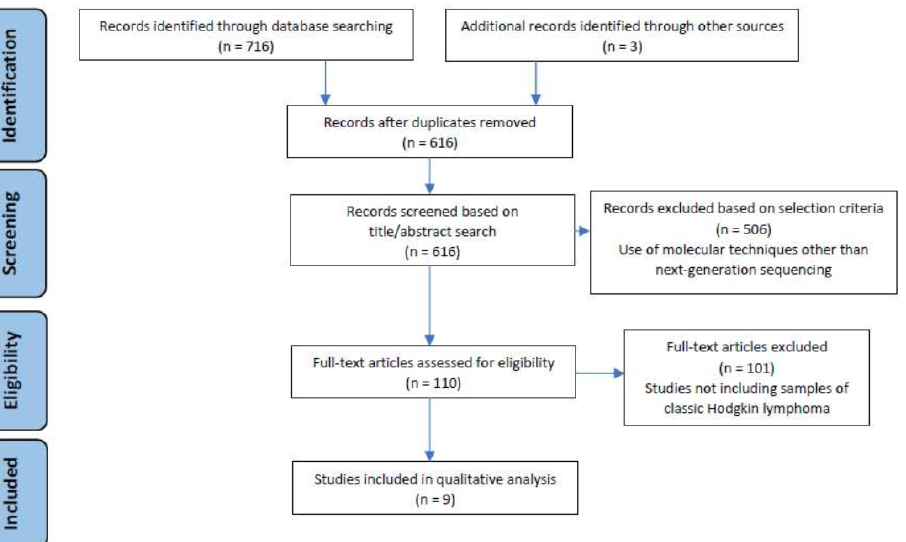
Figure 1. Study selection flow diagram. The literature search was performed in the period January– February 2022 on Web of Science and MEDLINE databases, following the PRISMA guidelines